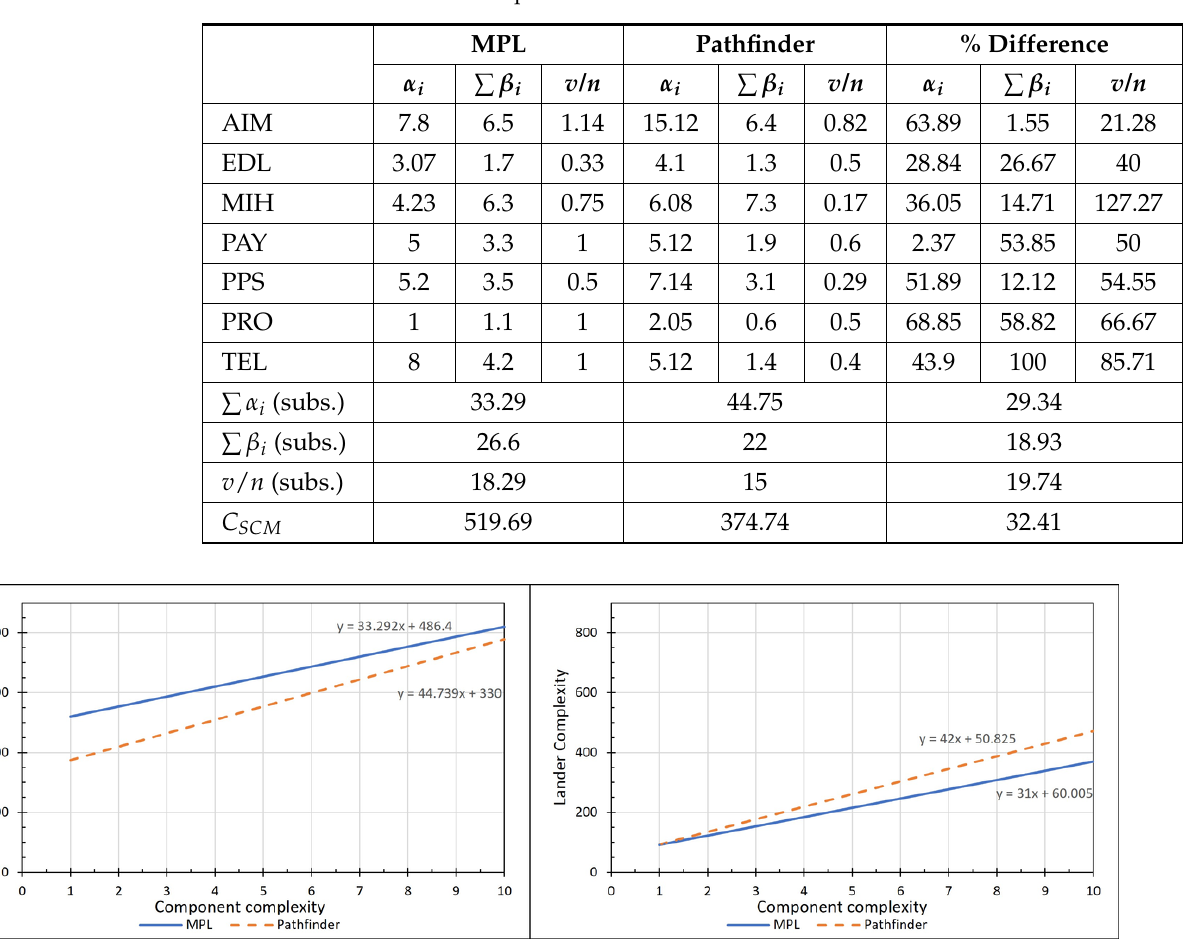
Table 3. Results of Lander Comparison.